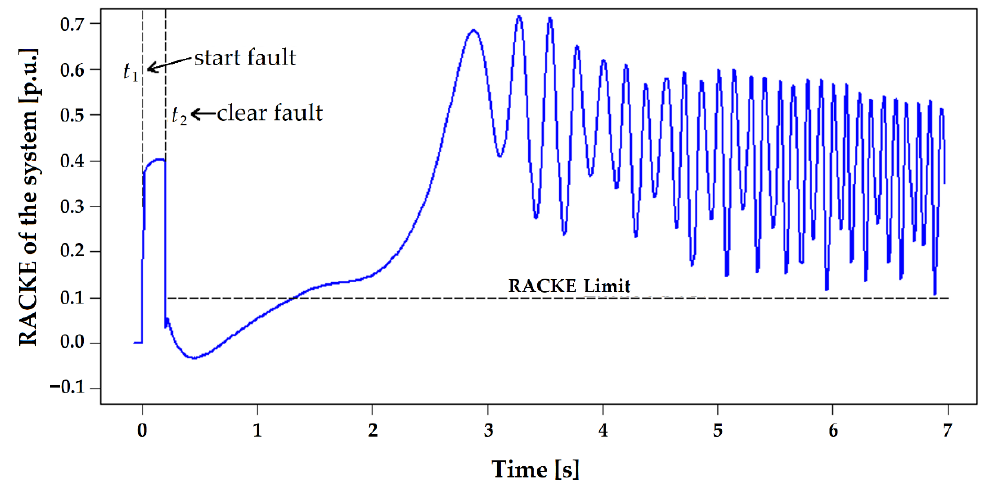
Figure 12. RACKE_SIS vs. time and the unstable case.